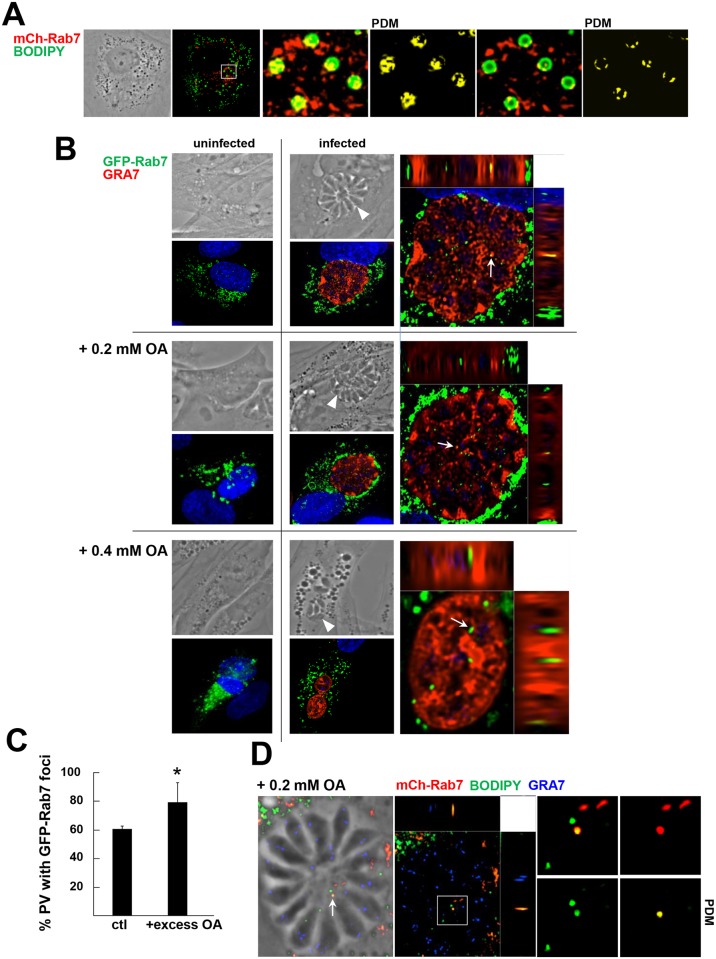
Detection of host Rab7-associated structures in the PV.A. Fluorescence microscopy of HFF expressing mCherry-Rab7. mCherry Rab7-expressing HFF incubated with 0.2 mM OA for 24 h were fixed and stained with BODIPY 493/503. A phase and a maximum projection (extended depth of field) image displaying the merge of BODIPY 493/503 (green) and mCherry Rab7 (red) are shown. A digital magnification of the boxed area is shown as two individual z-slice images displaying the merge of BODIPY 493/503(green) and mCherry Rab7 (red) plus the positive PDM, showing a subset of host LD containing Rab7 on their surface. B. Fluorescence microscopy of uninfected or 24 h-Toxoplasma-infected HFF expressing GFP-Rab7 grown without OA, with 0.2 or 0.4 mM OA. Cells were fixed and stained with antibodies for GRA7 (red; PV) and DAPI (blue; nucleus). Arrowheads pinpoint PV on phase images. The distribution of GFP-Rab7-positive vesicles (green) is shown in both uninfected and infected cells. A digital magnification of the Toxoplasma PV is shown in an orthogonal view of the z-stack to highlight the localization of host-derived GFP-Rab7 vesicles inside the PV (arrows). C. Quantification of the percentage of PV containing GFP-Rab7-associated structures in the PV lumen. Infected HFF expressing GFP-Rab7 were incubated in the absence of added OA (control) or with excess OA (0.2 or 0.4 mM) as described in B. The number of PV containing GFP-Rab7 structures was determined by analysis of microscopy images of optical z-stacks. Data are mean values ± SD (n = 3) (PV > 20 in each experiment). Values are statistically significant between PV exposed to OA (0.2 or 0.4 mM) and without OA as control (Chi-squared test, *p <0.0129). D. Fluorescence microscopy of mCherry-Rab7 expressing HFF infected with Toxoplasma for 24 h, and stained with BODIPY 493/503 (green) and GRA7 (blue). A phase and orthogonal view of a fluorescent z-stack are shown. A digital magnification of the boxed region displayed as individual z-slices showing the BODIPY 493/503 channel (green), the mCherry-Rab7 channel (red), a merged image and positive PDM. These images illustrate the co-staining of intravacuolar structures for mCherry-Rab7 and BODIPY 493/503 (arrow).